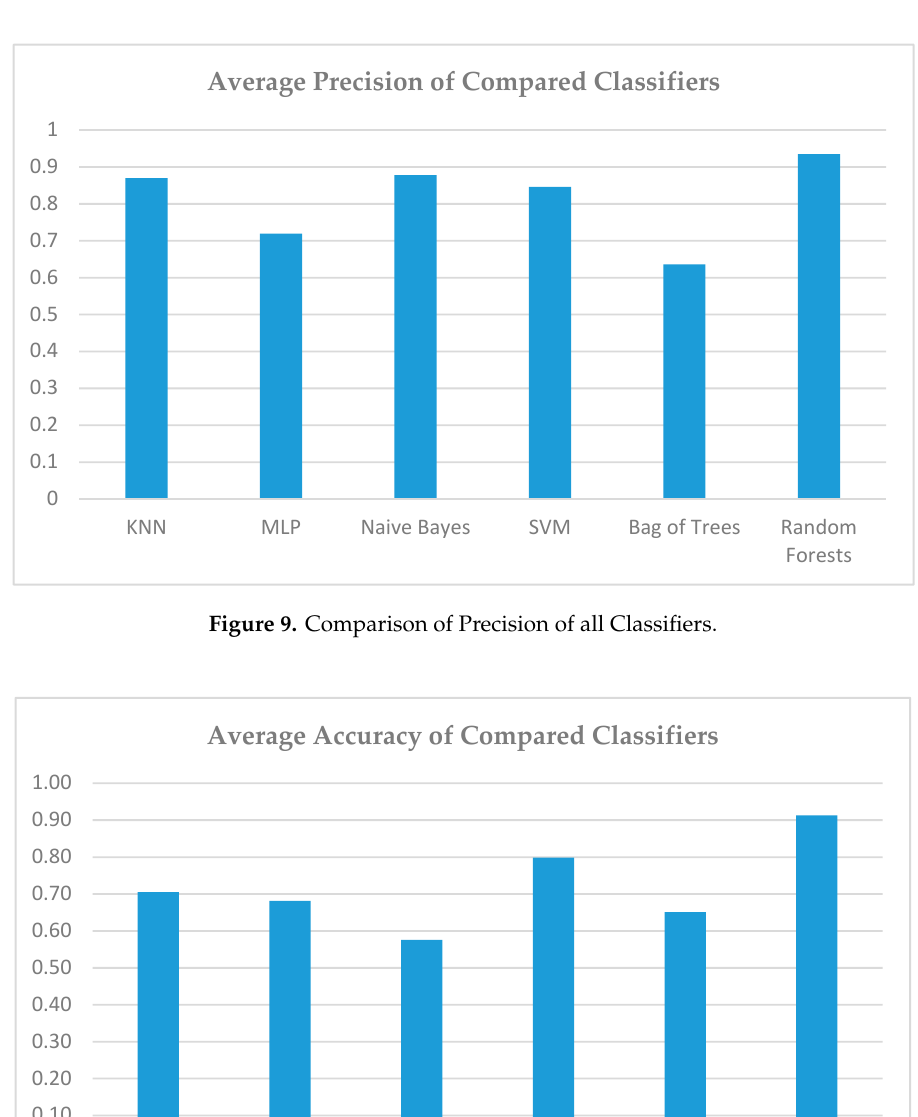
Figure 11. Comparison of Recall of all Classifiers.